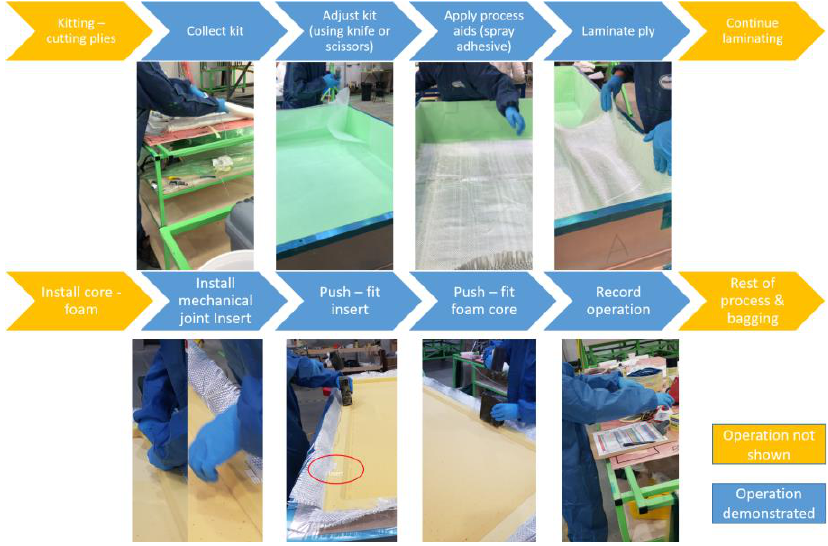
Figure 2. Composite-manufacturing process — manual operations